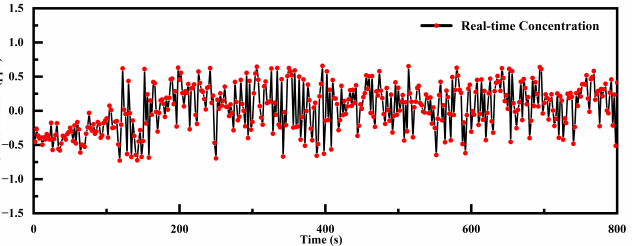
Figure 10. The measurement data of the system in 800 s in a N 2 atmosphere.